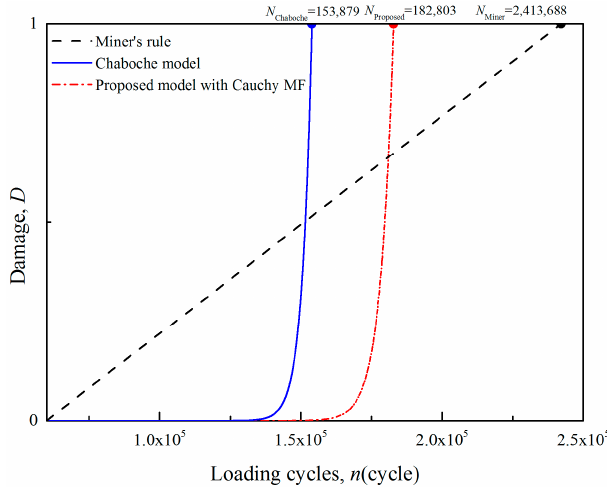
Figure 9. Damage predictions of blade using different models.